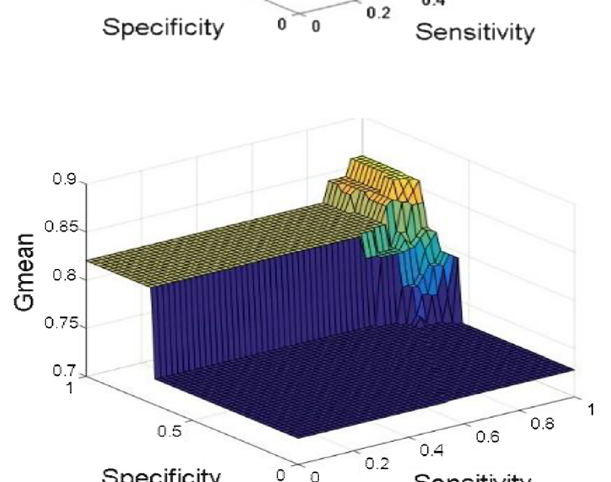
Figure 19: Sensitivity versus specificity versus Gmean (TLBO-ELM).